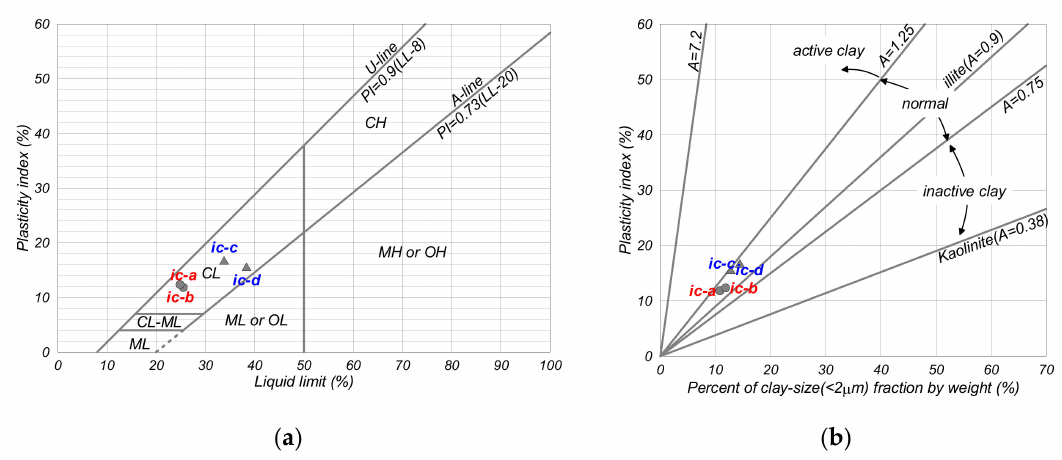
Figure 6. Physical properties of the Incheon region soil: ( a ) Plasticity chart; ( b ) Activity chart.